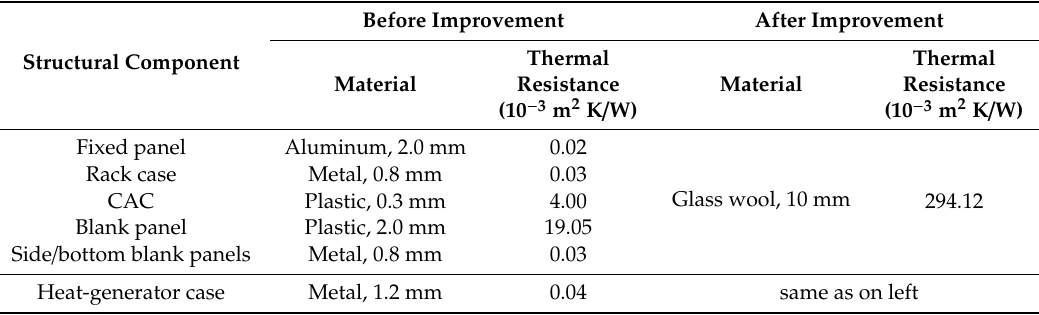
Table 8. Improvement measures for the thermal